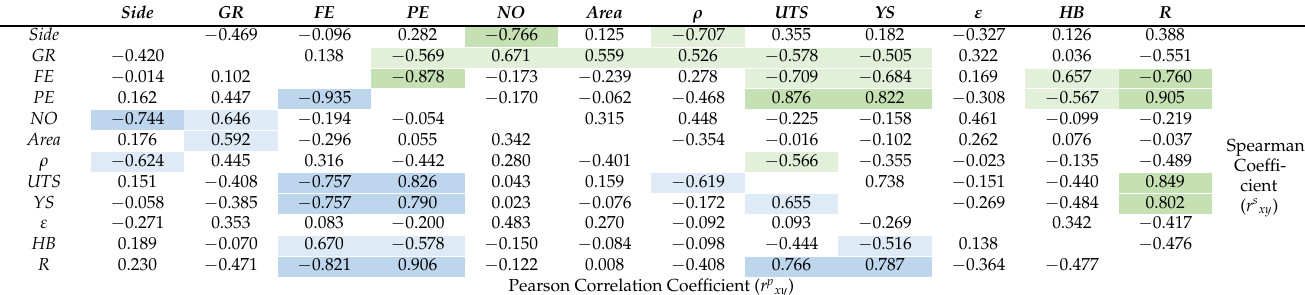
Table 6. Overview of the correlations between features according to the Pearson’s ( down ) and Spearmen’s ( up ) coefficients: higher correlations are highlighted by